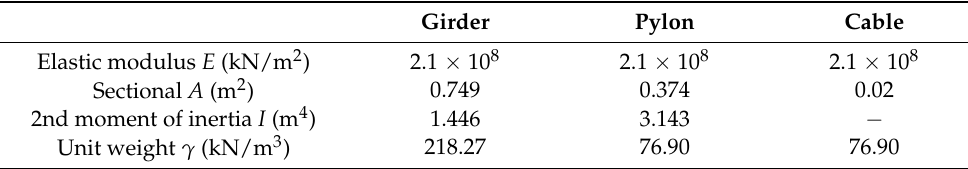
Figure 2. Validation model configuration. Table 1. Material and geometric properties of main members.